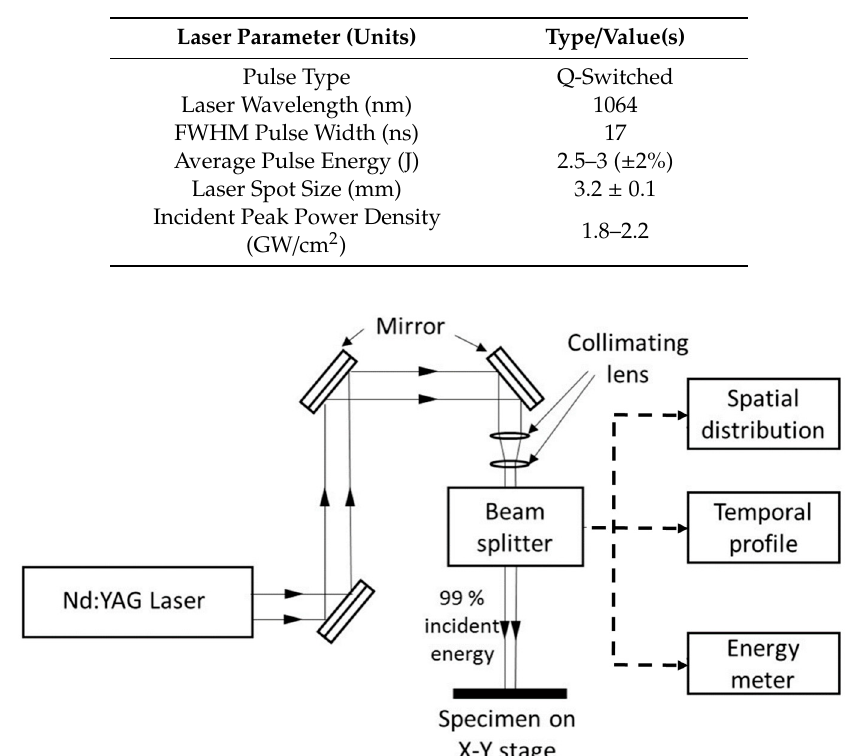
Table 1. Laser parameters [37,38], with permission from ASME, 2019.